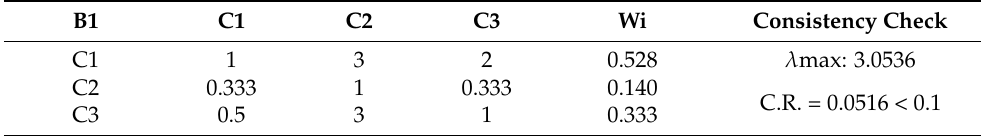
Table 10. B1–C judgment matrix and weight assignment.